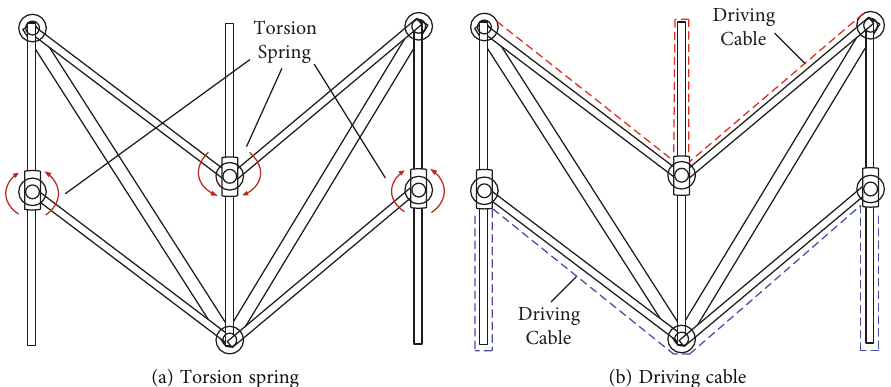
Figure 10: Driving scheme for the deployment of the ring truss